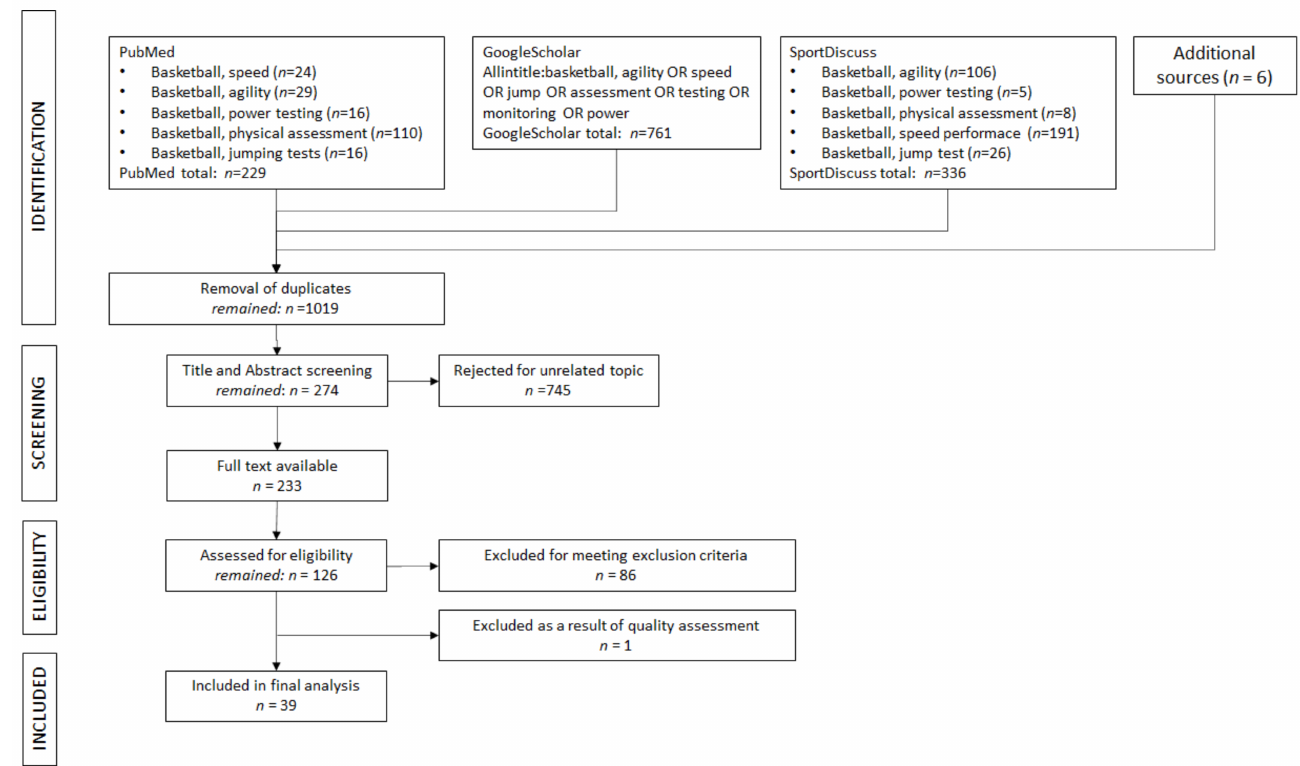
Figure 1. Flow diagram illustrating studies for inclusion in the review